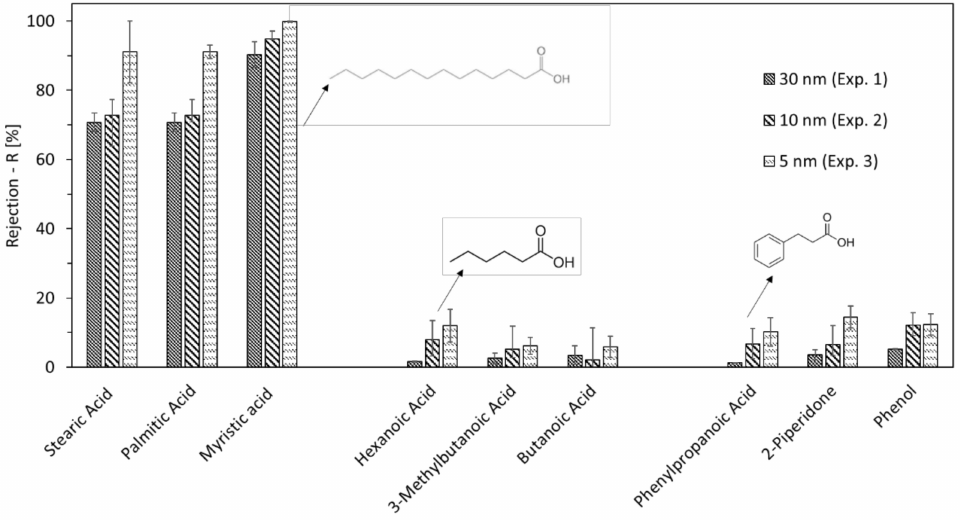
Figure 4. Rejection of long-chain fatty acids (stearic acid, palmitic acid and myristic acid), short- chain fatty acids (hexanoic acid, 3-methylbutanoic acid and butanoic acid) and cyclic compounds (phenylpropanoic acid, 2-piperidone and phenol) for UF membranes-pore sizes of 30, 10 and 5 nm in experiments 1, 2 and 3,